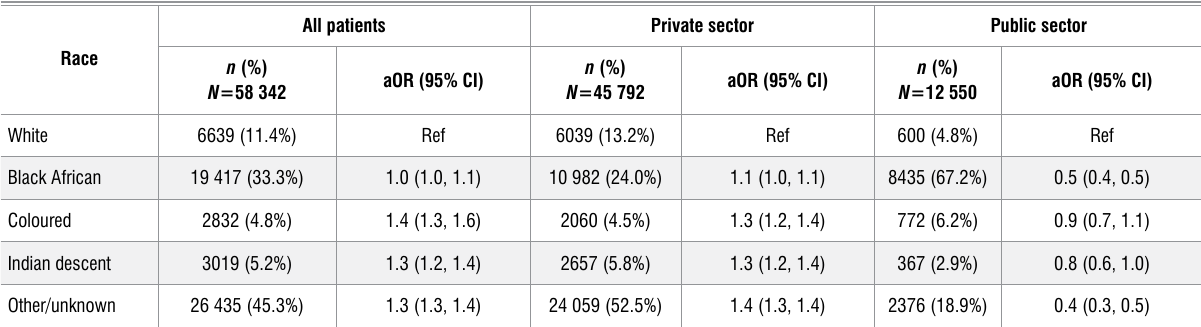
Factors associated with being treated in ICU, among (1) all patients, (2) private sector patients, and (3) public sector patients, South Africa,